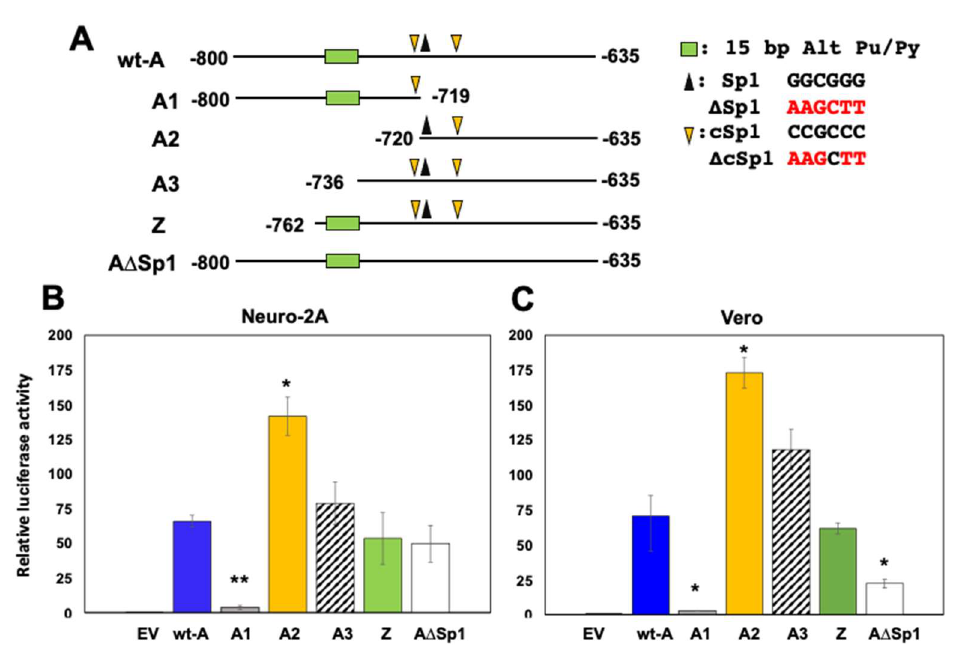
Figure 2. Localization of ICP0 fragment A that exhibits CRM activity. ( Panel A ): Schematic of ICP0 wt−A fragment with transcription factor binding sites and mutants used in the study. A1 and A2 contain the 5′ half and 3′ half of the wt-A fragment. Fragment A3 contains all Sp1 and cSp1 binding sites but lacks the 15−base alternating purine/pyrimidine motif. Fragment Z contains the alternating purine/pyrimidine motif (CGCGCATATATACGCTTG) and all Sp1/cSp1 binding sites. The A∆Sp1 construct has mutations in all Sp1/cSp1 binding sites. All constructs were cloned into the pGL4.24[luc2P/minP] vector such that the fragment is upstream of the minimal promoter. Nucleotide position numbers shown are relative to the ICP0 mRNA initiation site. Nucleotide sequence of Sp1 and cSp1 sites (black) and mutants (red) are shown to the right of panel A. Neuro−2A ( Panel B ) or Vero ( Panel C ) cells were transfected with 0.5 µg with the wt A construct or designated A mutant and Renilla luciferase plasmid (0.05 µg). 48 h after transfection, cells were harvested, and dual luciferase assay was performed. Luciferase activity was calculated relative to pGL4.24[luc2P/minP] for each construct. Results are the mean of three experiments, and the error bars indicate standard error. The * and ** denote a significant difference of p < 0.05 and p < 0.005 respectively compared to the wt-A CRM luciferase activity as determined by Student’s t-test. Statistical analysis was performed as described in Materials and Methods.